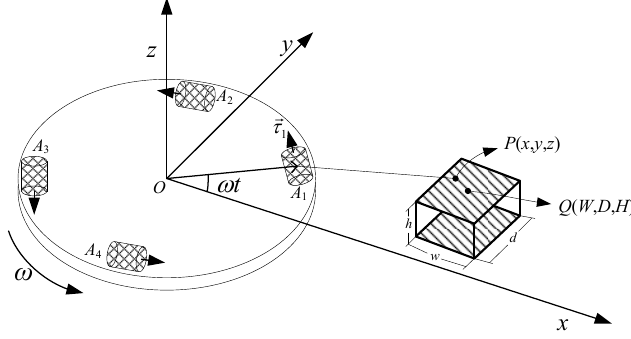
Figure 5. Schematic diagram for the cuboid act on the